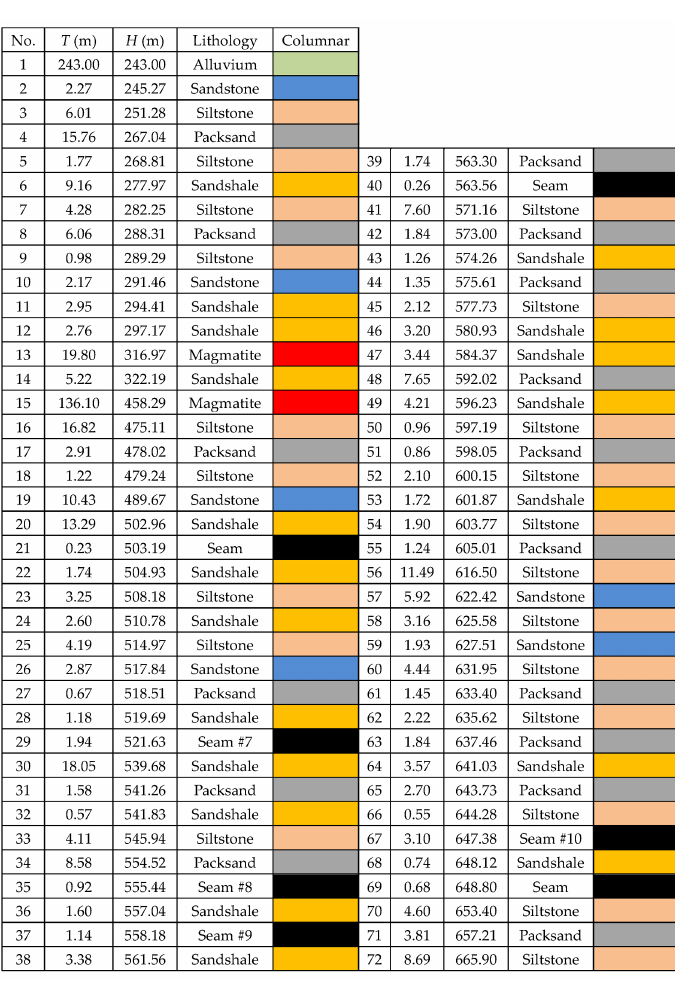
Figure 5. Five types of specimens.